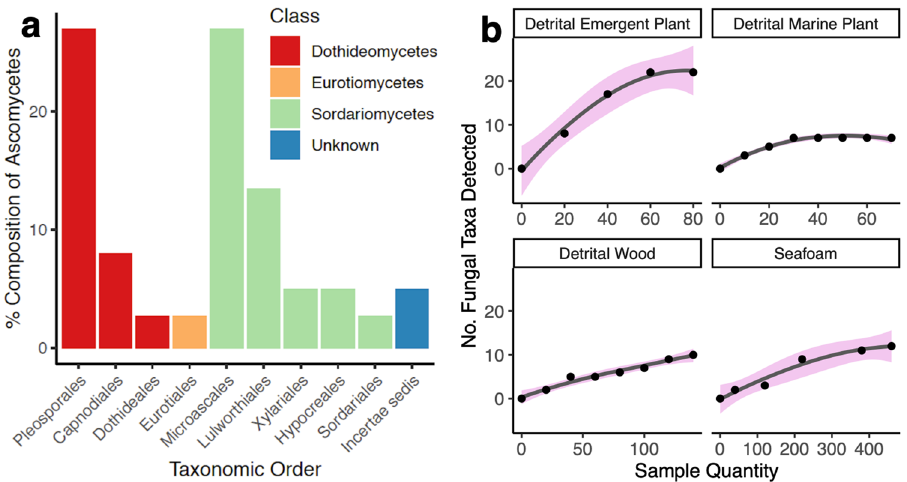
Figure 2. ( a ) Taxonomic composition of ascomycetes identified morphologically during this study (expressed as a percentage of the total [288]). ( b ) Relationship between the number of taxa detected morphologically and the number of samples collected for each sample